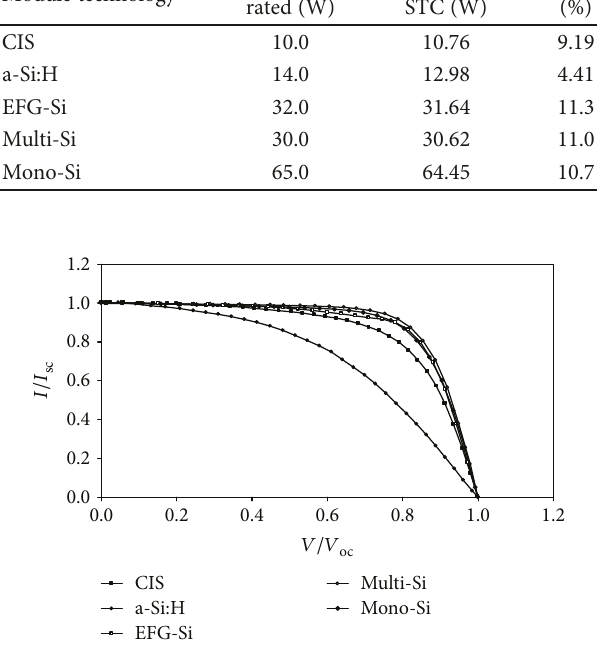
Figure 11: Normalized I-V characteristics of the fi ve module technologies used.